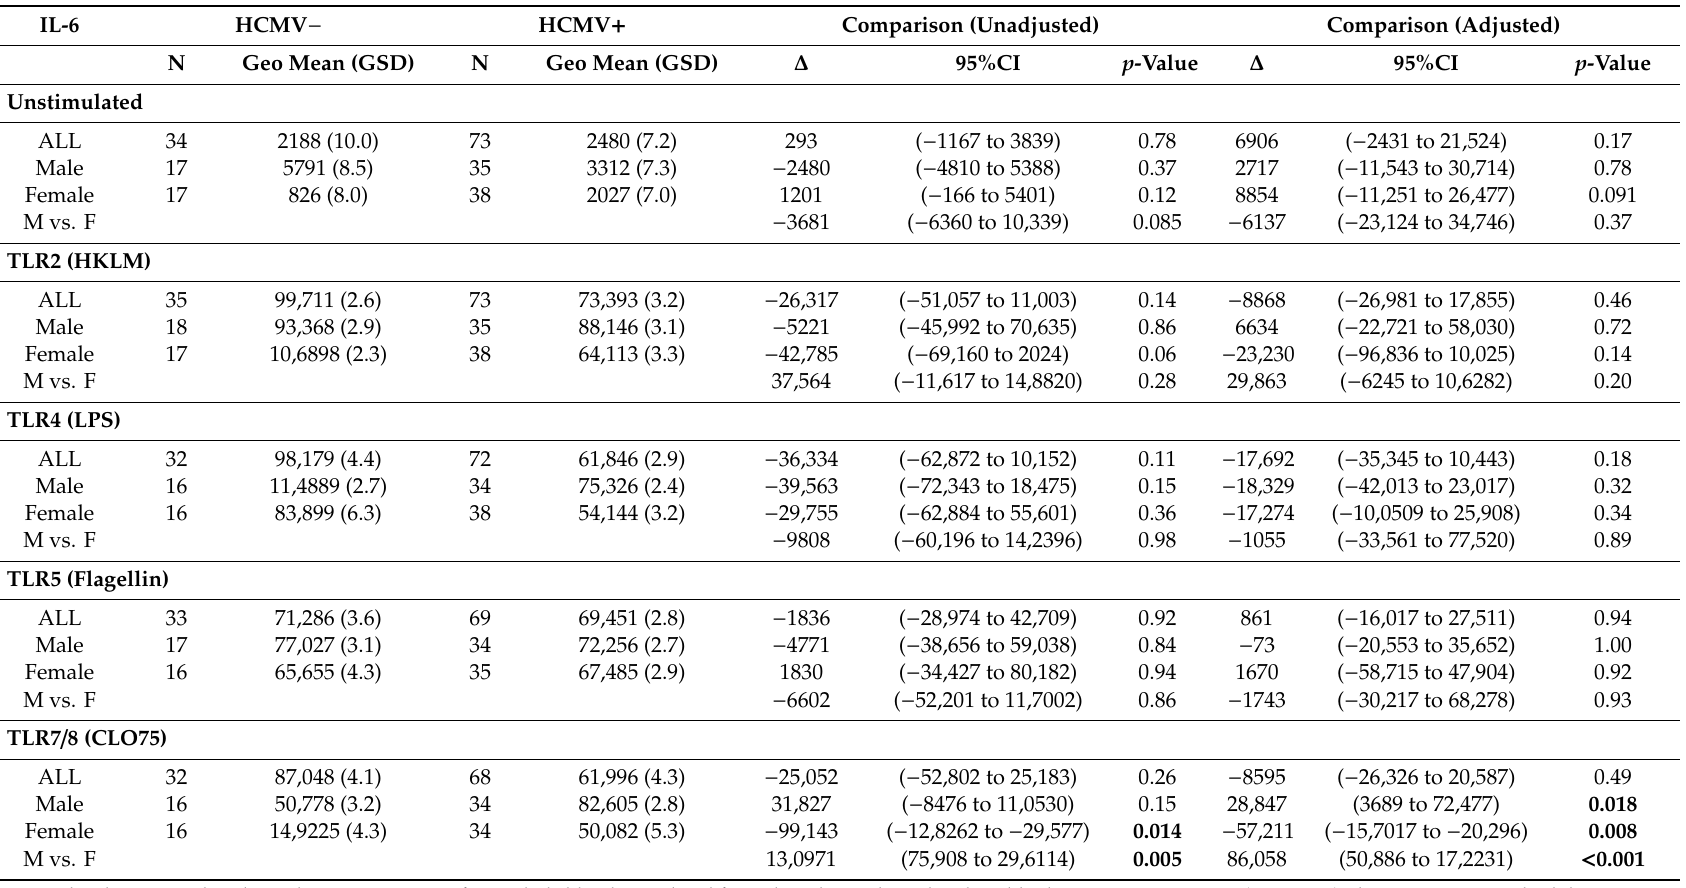
Table 4. E ff ect of HCMV infection on TLR ligand-stimulated IL-6 responses by infant